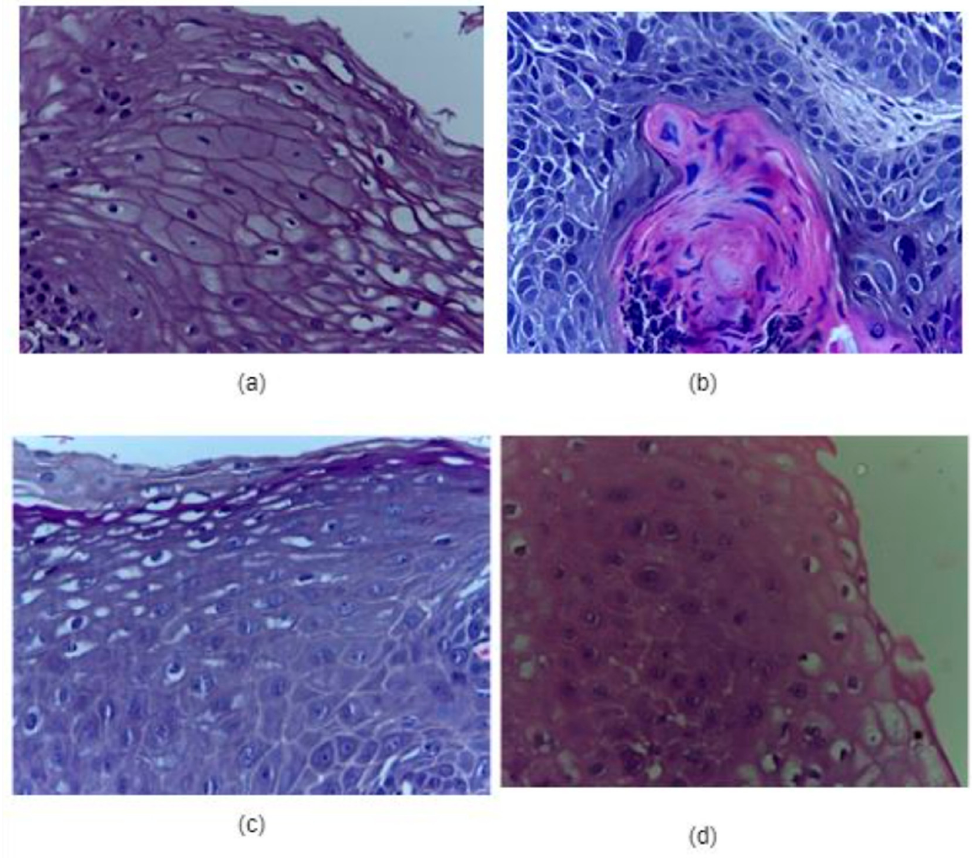
Figure 1. ( a ) Normal cell (100 × magnification), ( b ) cancerous cell (100 × magnification), ( c ) normal cell (400 × magnification), ( d ) cancerous cell (400 × magnification).